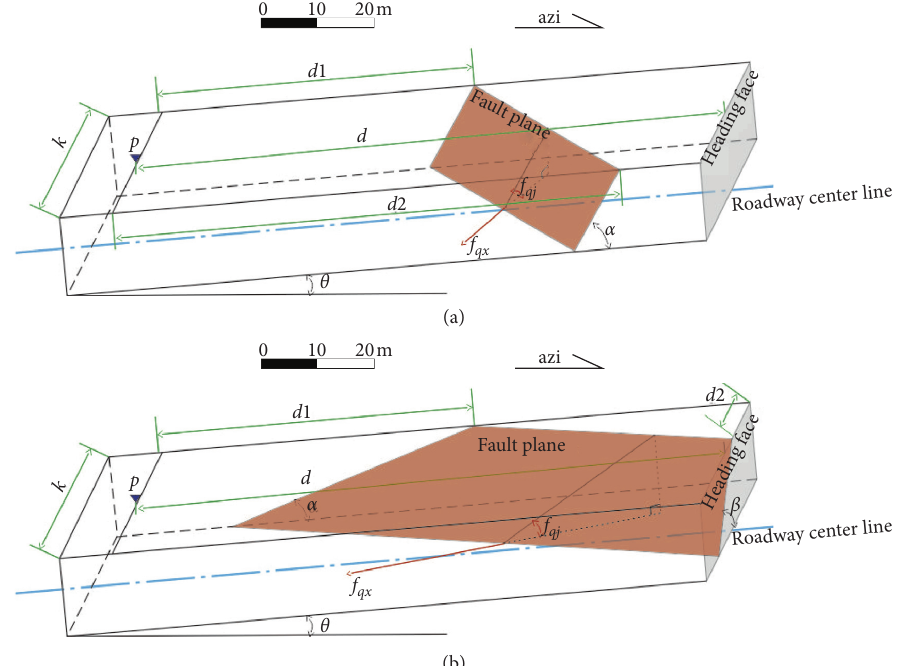
Figure 2: Diagram of calculation parameters for faults cutting the roadway. (a) A fault cutting through both sides of the roadway. (b) A fault cutting through one side of the roadway and the heading